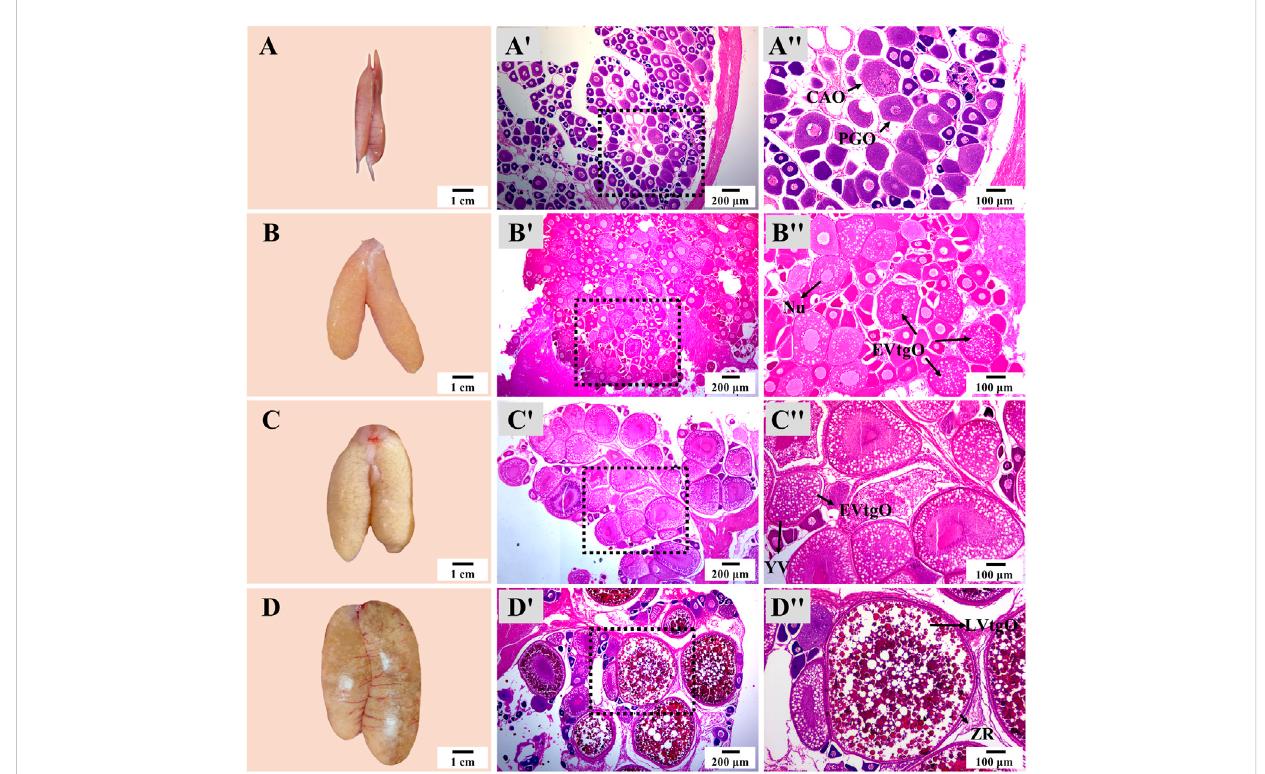
FIGURE 6 Ovaryappearanceandhistologyduringthermo-photoperiodmanipulationoflargemouthbass. (A – D) OvaryappearanceatStage1,Stage2,Stage3, andStage4,respectively,showingremarkablechangesinovariansizeandappearance. (A ʹ – D ʹ ) CorrespondingovarianhistologyatStage1,Stage2,Stage 3,andStage 4, respectively, showingthedramatic changesinthesizeand composition ofoocytes. (A ʺ – D ʺ ) Represent theenlargementofthedottedbox in the histological image of (A ʹ – D ʹ ) , respectively. Stage 1 , before the initiation of ovarian redevelopment, before temperature decrease, 16 August. Stage 2 , supposed maturation of ovary, right after temperature increase, 25 September. Stage 3 , the supposed spawning period, 5 weeks after the maintenanceofspawningtemperature,31October. Stage4 ,thesupposedspawningpeak,spawningwasobservedinalltreatmentgroups,21November. PGO, primary growth stage oocytes. CAO, cortical alveoli stage oocytes. CA, cortical alveoli. EVtgO, early vitellogenesis stage oocytes. LVtgO, late vitellogenesis stage oocytes. YV, yolk